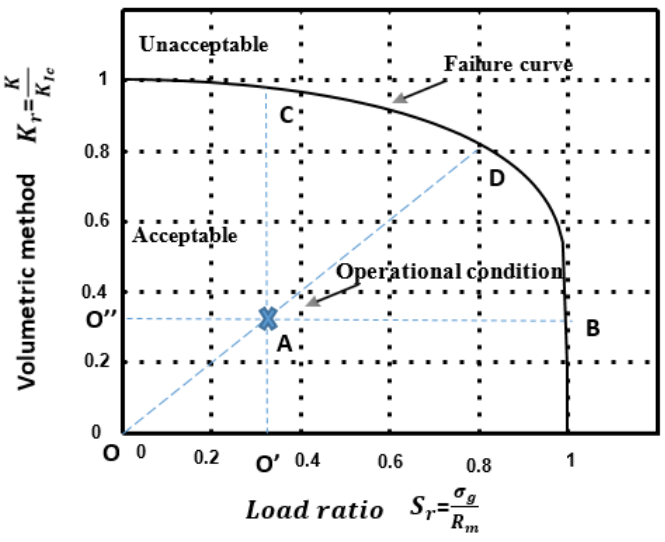
Figure 2. Assessment diagram failure.